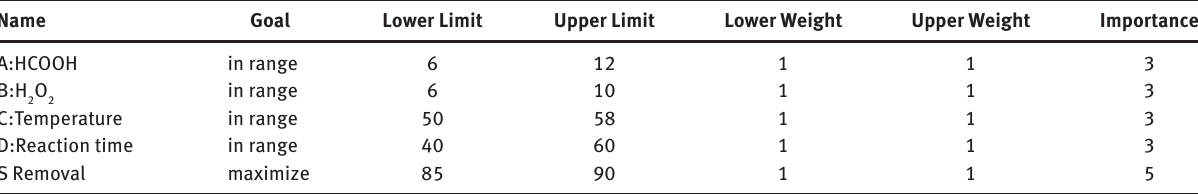
Table 6: Optimisation